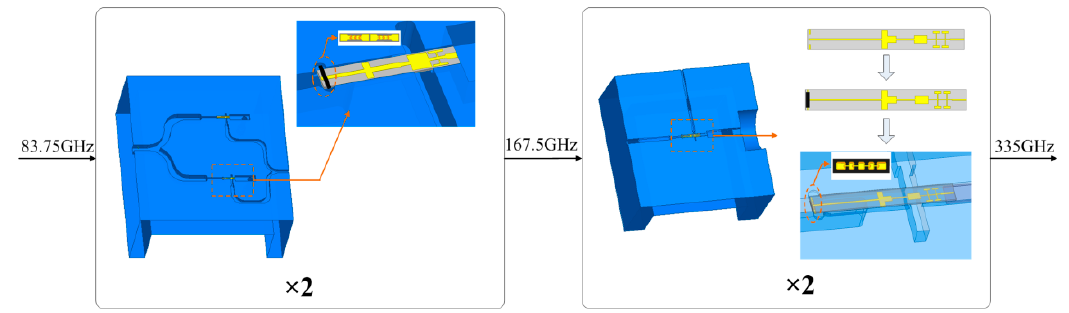
Figure 3. The three-dimensional model of the 335 GHz source based on a two-stage doubler.